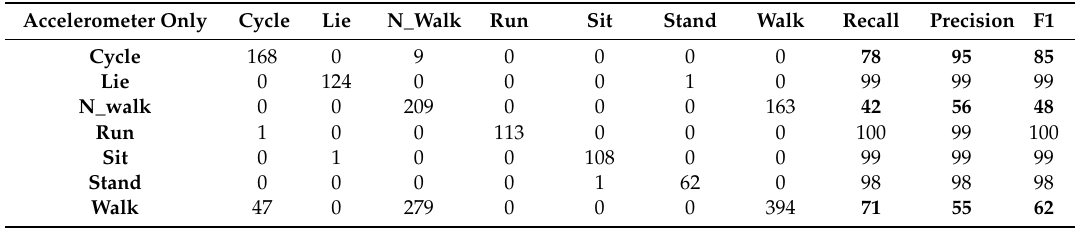
Table 5. Confusion matrix of a participant (with the highest GPS contribution) when using accelerometer and GPS data (Scenario 1).